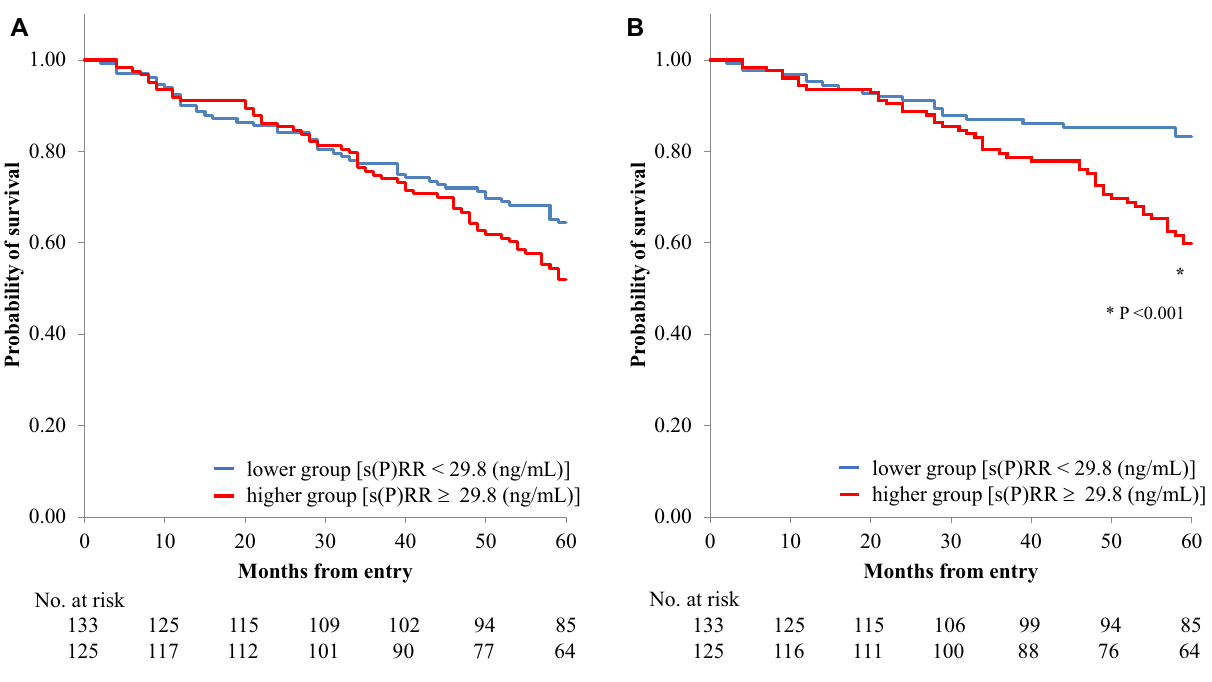
Figure 2. Probability of survival ( A , All-cause death; B , Cardiovascular death). Kaplan–Meier survival plots comparing patients with higher and lower serum concentrations of s(P)RR. s(P)RR, soluble (pro)renin receptor.